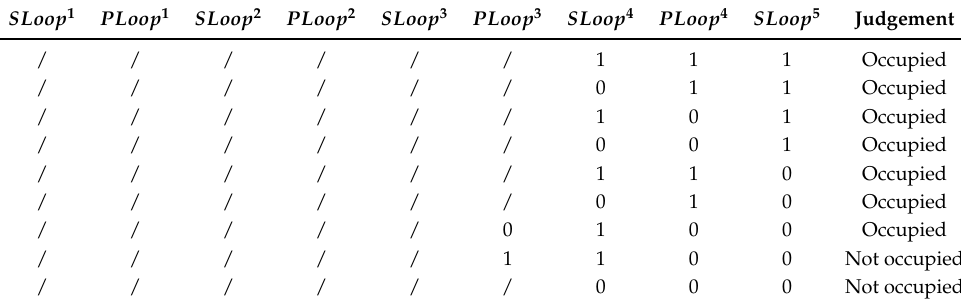
Table 3. Judgement of whether Lane 4 is